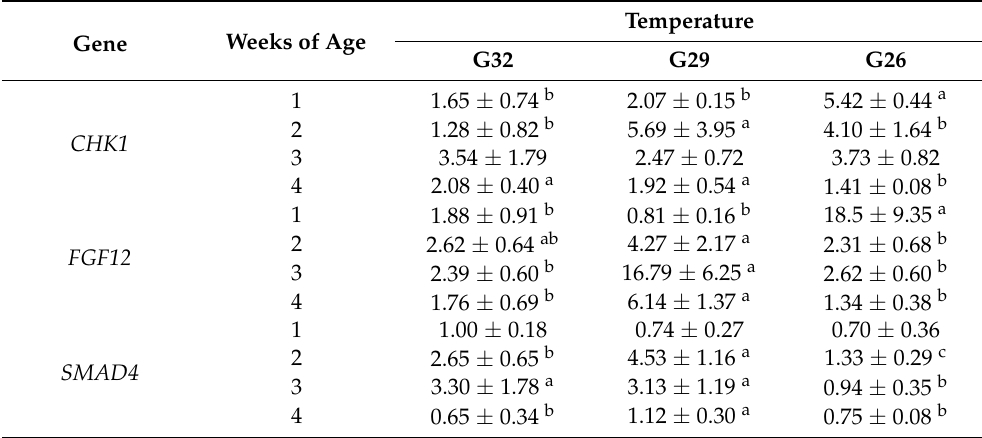
Table 5. Effects of temperature on mRNA expression of genes related to ovarian development in goslings at different weeks of age. Temperature Gene Weeks of Age G32 G29 G26